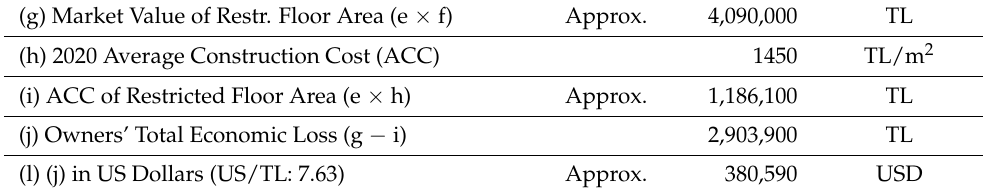
Table 1. Cont. (g) Market Value of Restr. Floor Area (e × f) Approx.